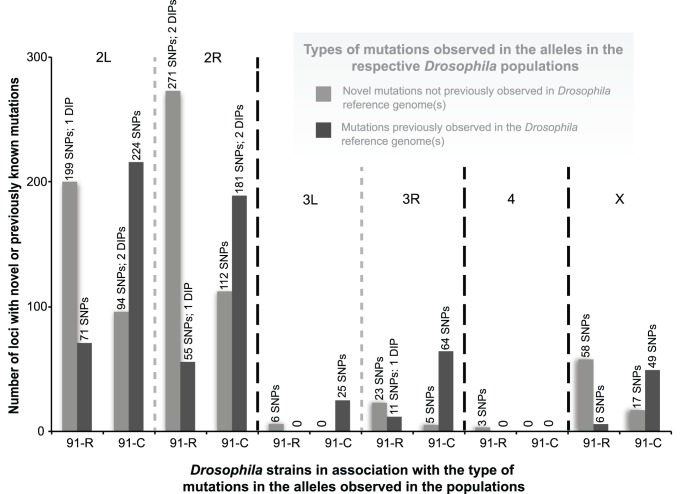
A comparison of allele fixation for the Drosophila melanogaster (Drosophila) fly lines 91-R and 91-C, in their respective populations, in relation to novel and previously known mutations.The figure represents only those mutations observed in the 91-R and 91-C genomes that caused amino acid structural changes in open reading frames (ORFs) resulting from a single nucleotide polymorphisms (SNPs) or deletion/insertion polymorphisms (DIPs). Observed allele fixation events separated into the individual Drosophila chromosomes (4 and X) or by chromosomal arms (2R, 2L, 3R, and 3L).